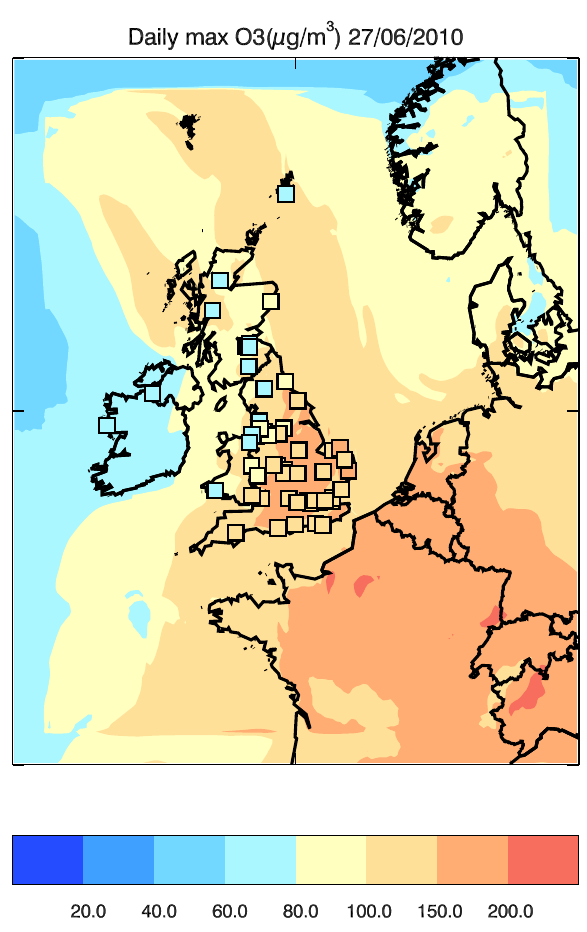
Fig. 9. Maximum modelled hourly ozone concentrations (µgm − 3 ) for 27 June 2010, with observed concentrations over-plotted within